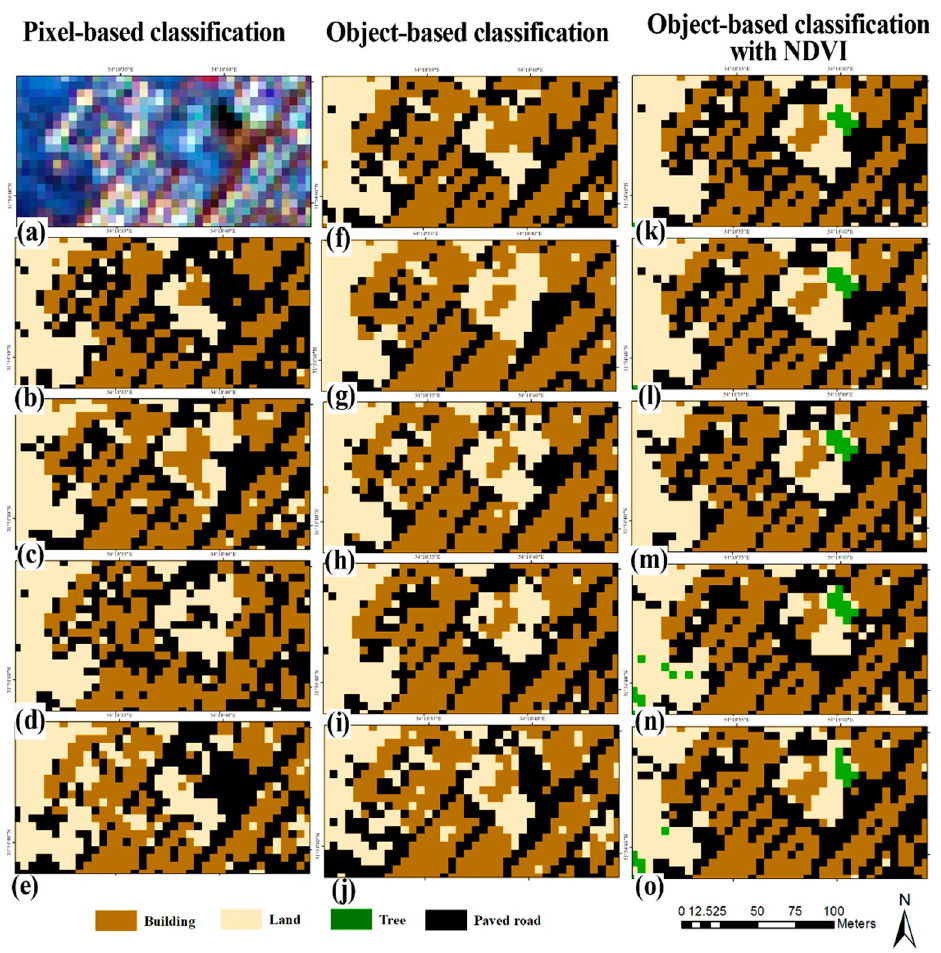
Figure 7. Classification of Sentinel-2 images obtained using pixel-based methods: ( a ) Sentinel-2 image, ( b ) maximum likelihood method, ( c ) minimum distance method, ( d ) spectral angle mapping (SAM) and ( e ) Mahalanobis method; object-based methods: ( f ) Bayes method, ( g ) support vector machine (SVM), ( h ) K-nearest neighbor (KNN), ( i ) decision tree (DT) and ( j ) random forest (RF); and object-based methods with normalized difference vegetation index (NDVI): ( k ) Bayes method, ( l ) SVM, ( m ) KNN, ( n ) DT and ( o ) RF.